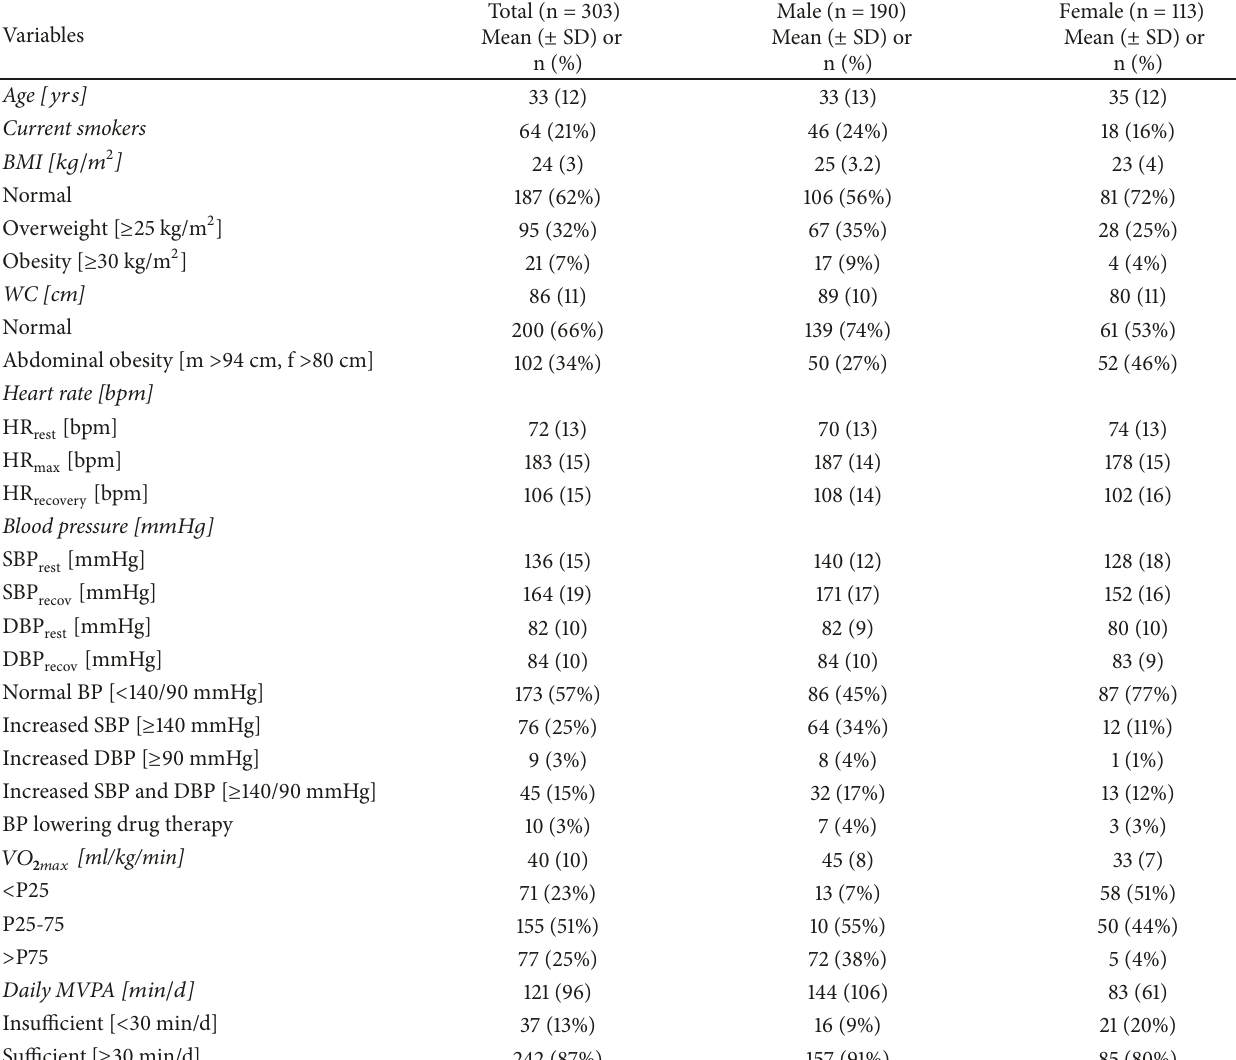
Table 1: Characteristics of study